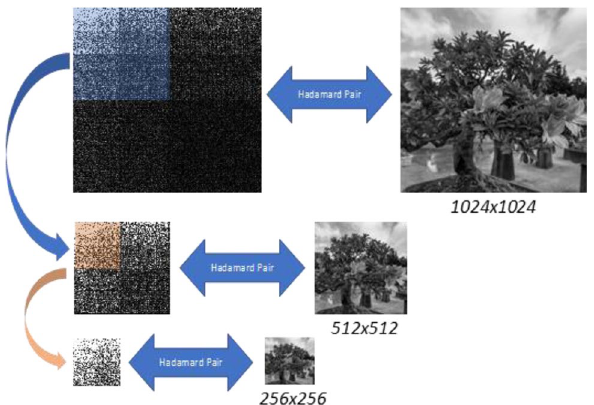
Figure 5. Illustration of the multiscale property of the 2D Hadamard transform (left) and the image (right). The upper left quadrant of the 2D Hadamard transform of an image (in blue) is a Hadamard transform of a lower resolution version of the image. Therefore, we can take the Hadamard samples highlighted in blue and reconstruct from them the 512 by 512 image. In turn, the upper left quadrant of the quadrant (in orange) is also a Hadamard transform of an even lower resolution image. Now, if we take the Hadamard samples highlighted in orange (or a quarter of the samples highlighted in blue) we can reconstruct the 256 by 256 image, directly from the Hadamard samples.